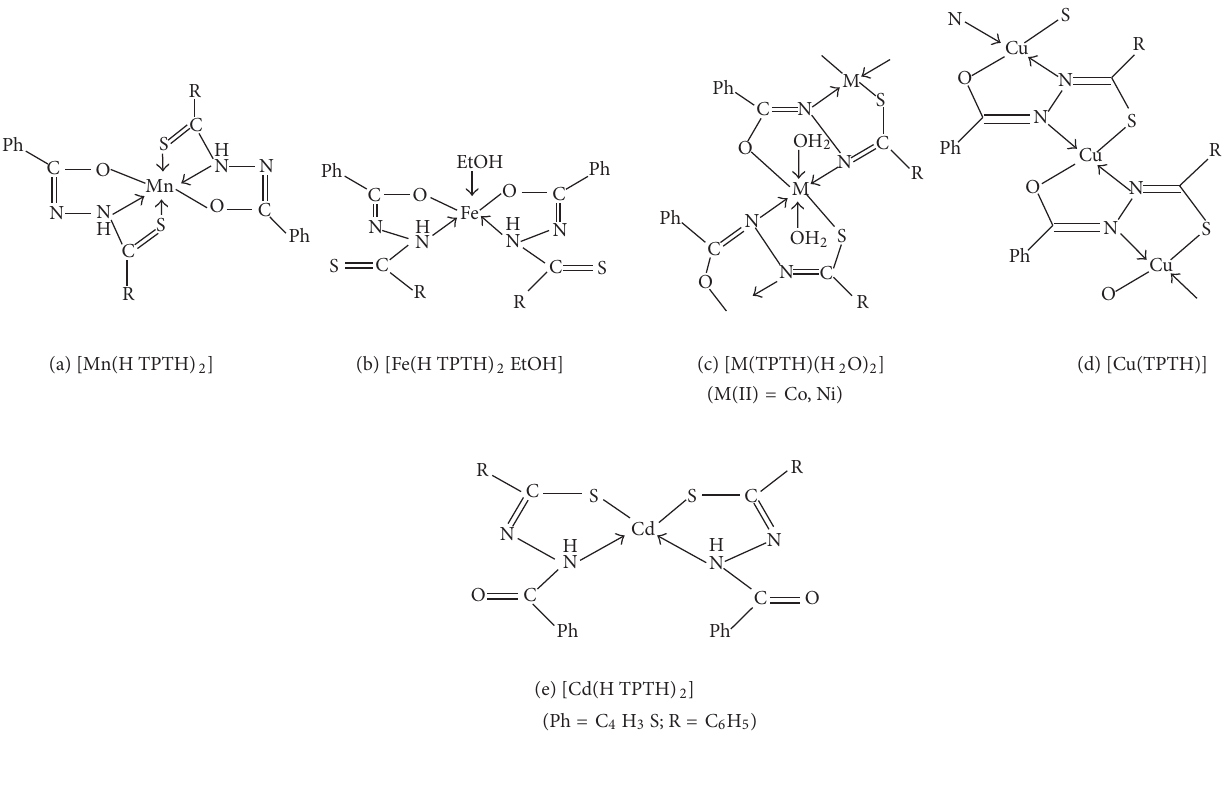
F 2: Proposed structure of the